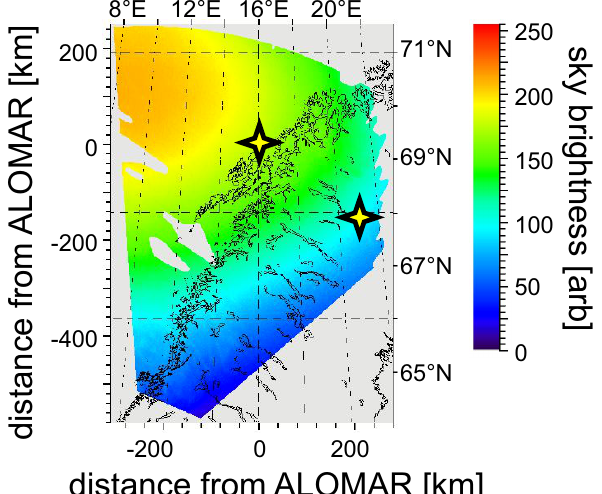
Fig. 8. Sky brightness observed from Trondheim on 3 August 2007 22:17UT mapped to a scattering layer at 82.5km altitude (cf. Fig. 7). The locations of ALOMAR and the Esrange are marked by black symbols. The colored area indicates the field of view of the camera, areas outside the field of view or contaminated by tropo- spheric clouds are grayed out. The picture is cut off at about 23 ◦ E due to the trees in the original picture. A large amount of the sky brightness is caused by Rayleigh scattering on molecules in the at- mosphere. NLC structures are barely visible as the sun is only 8 ◦ below the